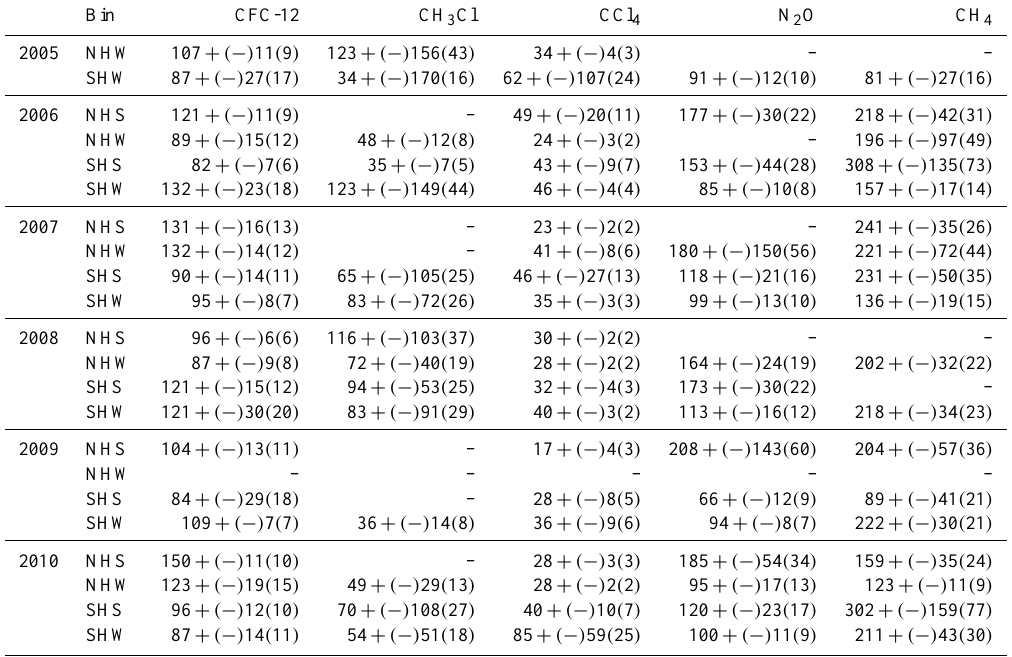
Table 3. The calculated lifetimes (yr) of CFC-12, CCl 4 , CH 4 , CH 3 Cl and N 2 O using a CFC-11 lifetime of 45yr. NHS is Northern Hemisphere summer, NHW is Northern Hemisphere winter, SHS is Southern Hemisphere summer, SHW is Southern Hemisphere